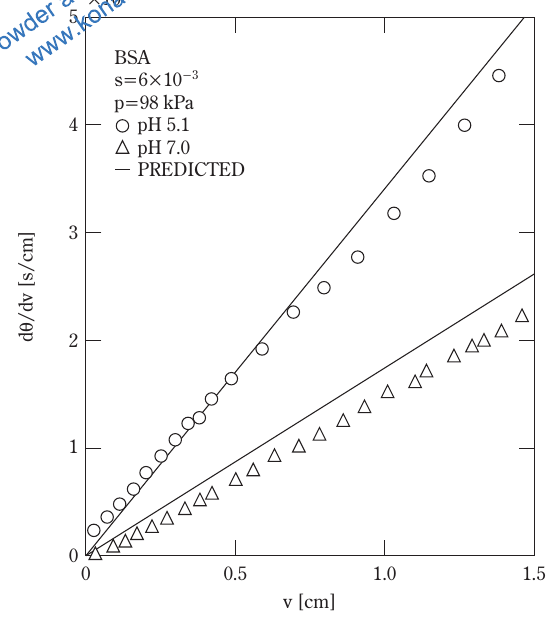
Fig. 10 Evaluation of filtration rate based on ultracentrifugation data.